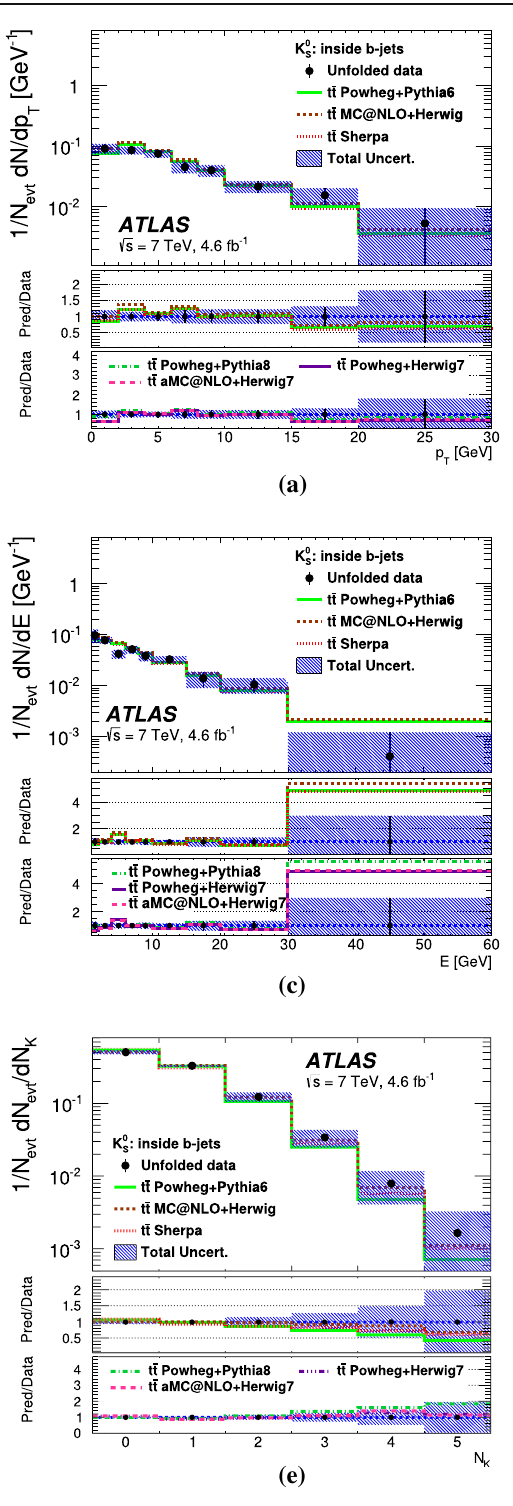
Powheg + Herwig7 and a MC@NLO + Herwig7 generators. Total Fig. 8 Kinematic characteristics for K 0 production inside b -jets, for S correcteddataandparticle-levelMCeventssimulatedwiththe Powheg uncertainties are represented by the shaded area. Statistical uncertain- + Pythia6 , MC@NLO + Herwig , Sherpa , Powheg + Pythia8 , ties for MC samples are negligible in comparison with